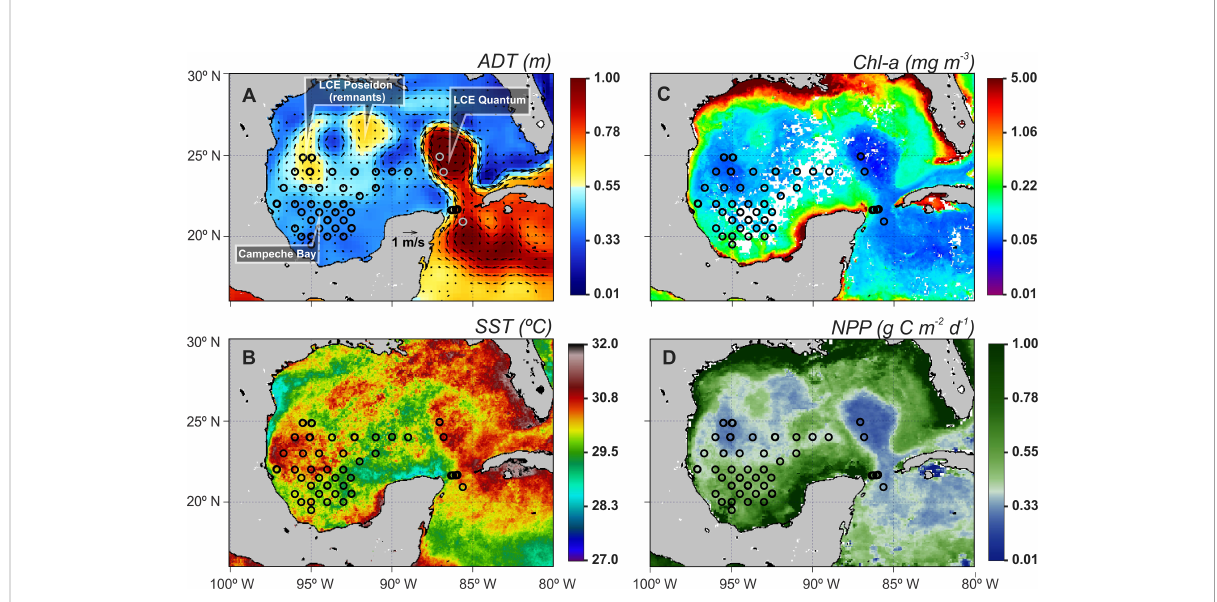
FIGURE 2 Satellite-derived images of (A) absolute dynamic topography (ADT; color scale) and geostrophic velocity (arrows), (B) sea surface temperature (SST), (C) chlorophyll a (Chl-a), and (D) net primary production (NPP) during the XIXIMI-6 cruise. Each panel represents a 21-day composite image that spans from August 19 to September 8, 2017. The locations of anticyclonic Loop Current eddies (LCE) are indicated in (A)